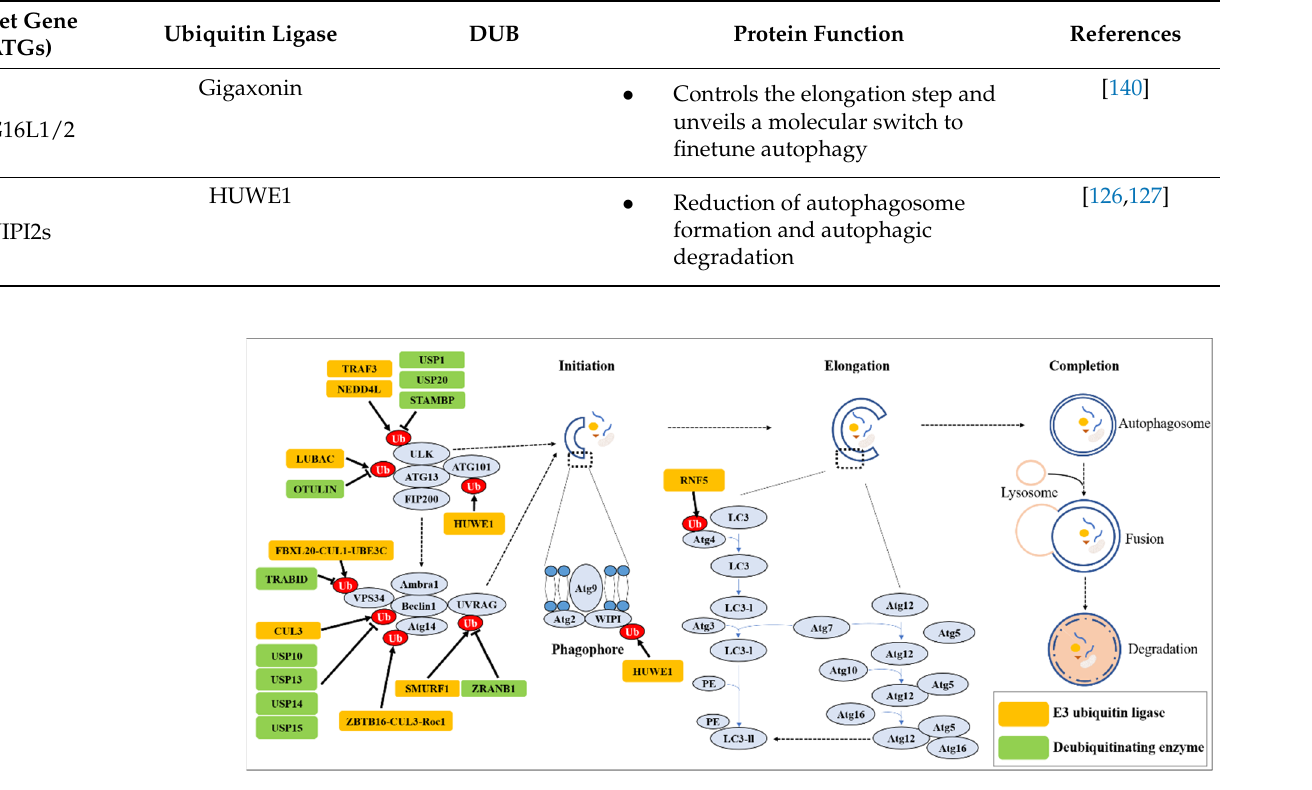
Figure 1. The role of E3 ubiquitin ligases and DUBs during autophagy process. Table 2. Ubiquitin ligases and deubiquitinating enzymes that regulate ATG proteins.